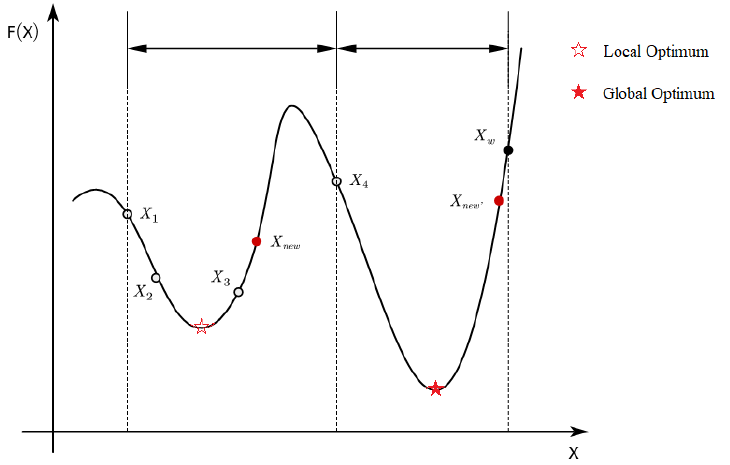
Figure 2. Potential advantages of using the worst individual to generate a new individual. Motivated by these observations, we endeavor to propose an enhanced BSO algorithm based on modified Nelder–Mead (MNM) and elite learning mechanism. First, the Nelder– Mead method is modified and used as a local search engine to fully explore more promising evolutionary direction, which can improve the exploration ability of the population. Next, the elite learning mechanism is used to enhance the exploitation ability for the evolution of the population. Finally, when the population is stagnant, the opposition learning strategy is employed to re-initialize the parent individual, which can make the population diverge into large search area and increase possibility to jump out of the local